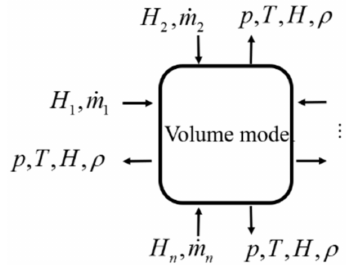
Figure 8. Interface parameters of volume model.